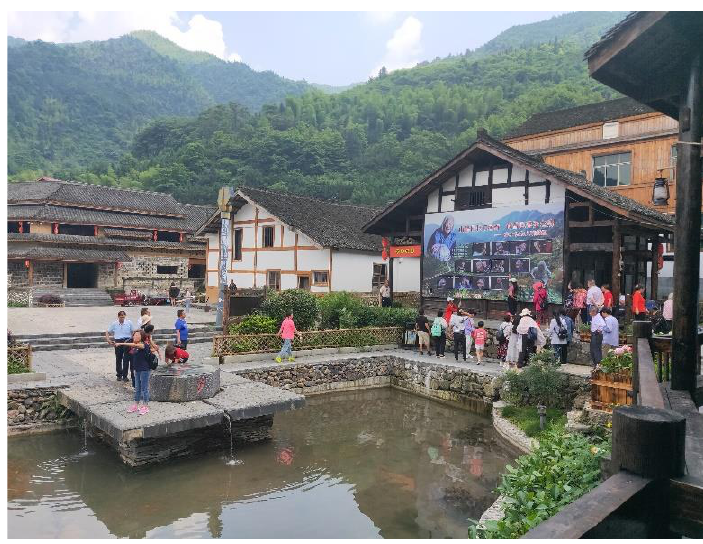
Figure 12. Baishuidong village in Hunan province (4.4 policy factors).